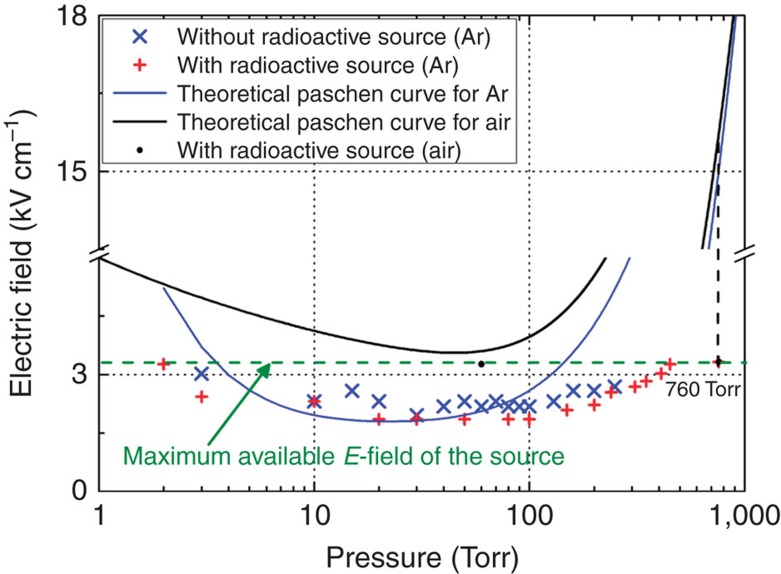
Measured threshold fields for breakdown and theoretical Paschen curves for Ar and air.All of the points (blue crosses, red plus signs and black circles) represent measured data, and the lines (black and blue) represent the theoretical curves. For Ar, measured data are depicted for the cases without radioactive material (blue crosses) and with 0.64 mCi of 60Co (red plus signs). The measured threshold electric field had 0.15 kV cm−1 variance. The electromagnetic (EM) wave power was not sufficiently high to induce breakdown in the absence of the external radioactive source at pressures >250 Torr in Ar. However, even though the output power of the gyrotron was insufficient to initiate avalanche ionization, saturation breakdown is observable even at 460 Torr, due to the generation of free electrons by the 60Co source. The maximum output electric field of the gyrotron, ∼3.49 kV cm−1, is below the required threshold electric field (∼15.7 kV cm−1 at 760 Torr in Paschen curve) in Ar and air (black dotted vertical line). However, the observed plasma breakdown indicated by the black circles at 60 Torr and 760 Torr in air and 760 Torr in Ar present the possibility of plasma breakdown in the presence of radioactive material at powers lower than those predicted theoretically.